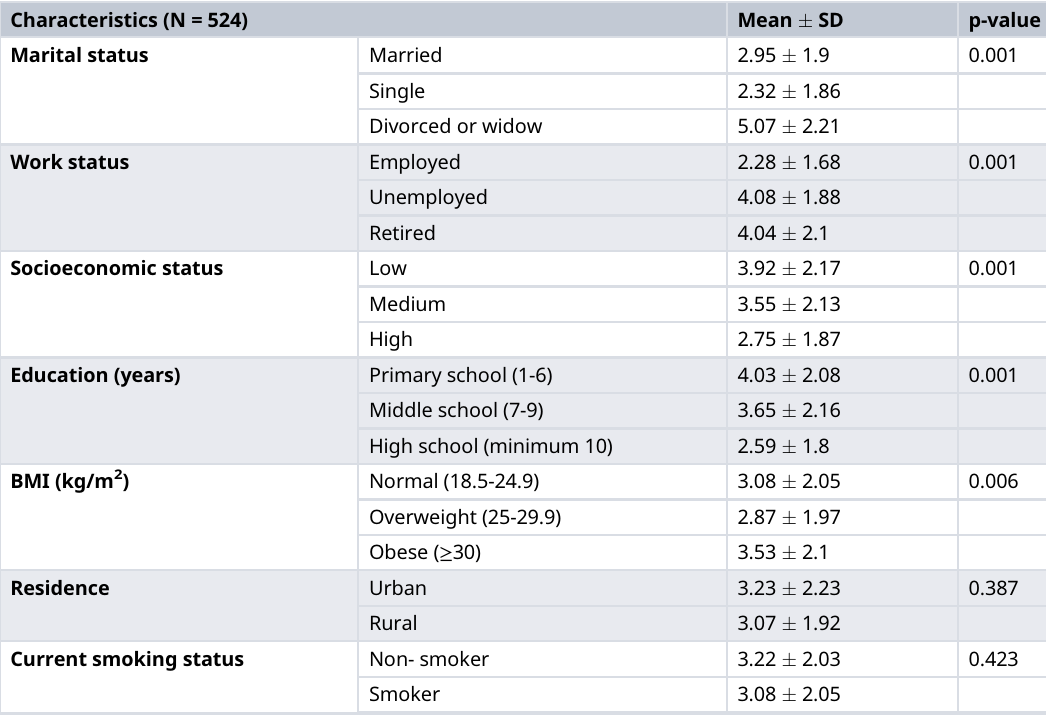
Table 2. Bivariate analysis of the participants ’ characteristics.